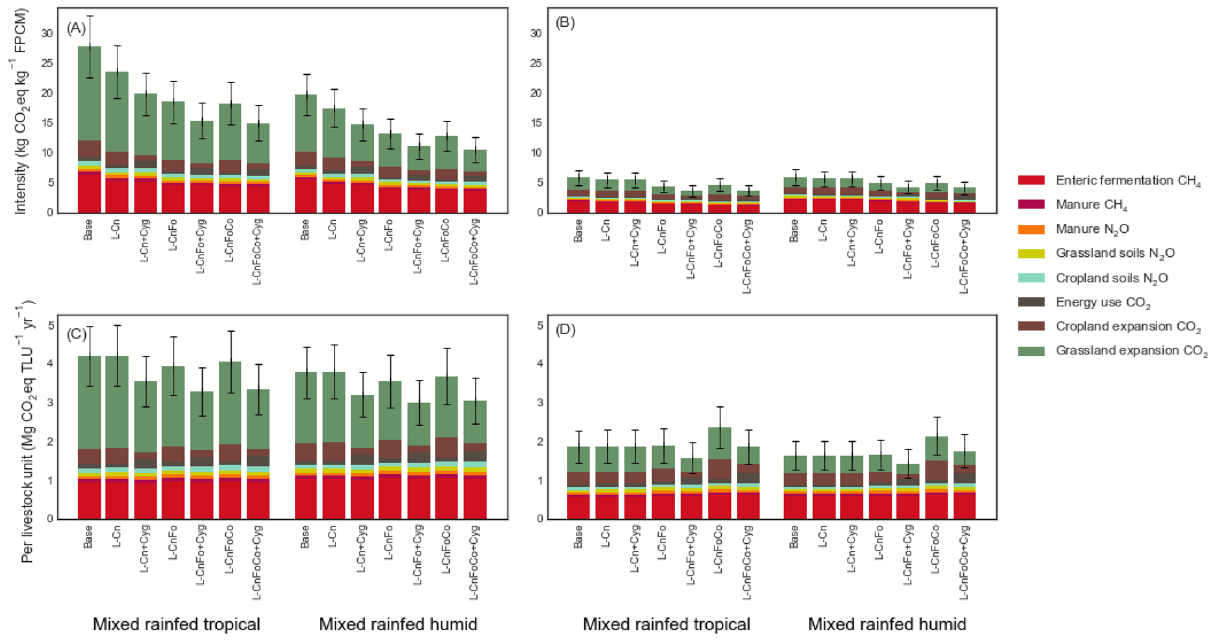
Figure 3. Greenhouse gas emissions for Traditional ( A , C ) and Modern ( B , D ) dairy